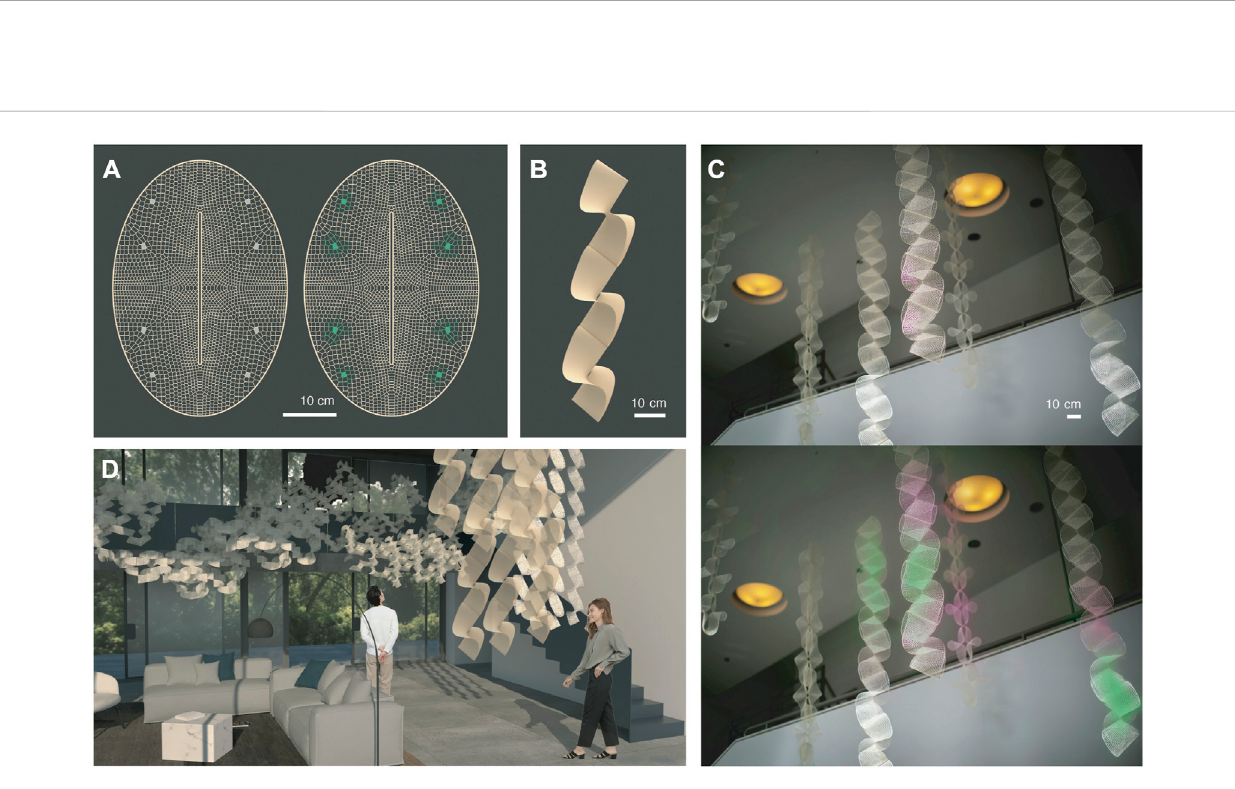
FIGURE 4 Macroscale Design Methodology. (A) Computationally designed functionally graded cell size distribution throughout lattices promotes folding, structural inertia, and attachment areas for biosites. (B) Geometries programmed also allow arrangement into ribbon structures able to hang from ceilings. (C) With potential to biologically sense and react to air in future work, ribbons provide adequate surface area and rotation to be integrated into indoor environments shown in (D)